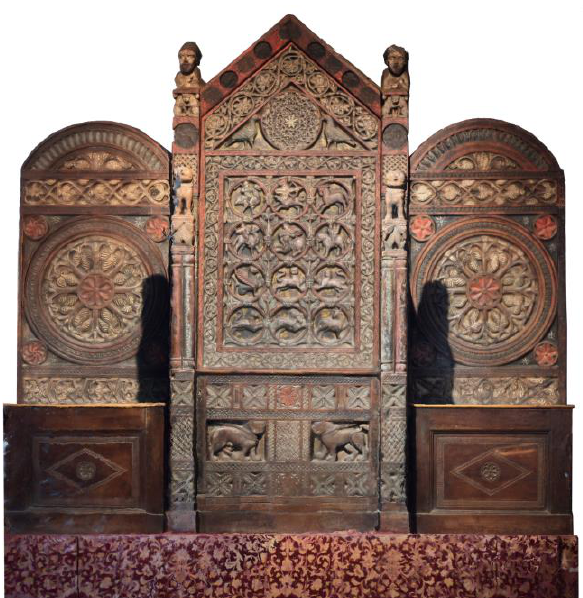
Figure 11. Orthophoto of the